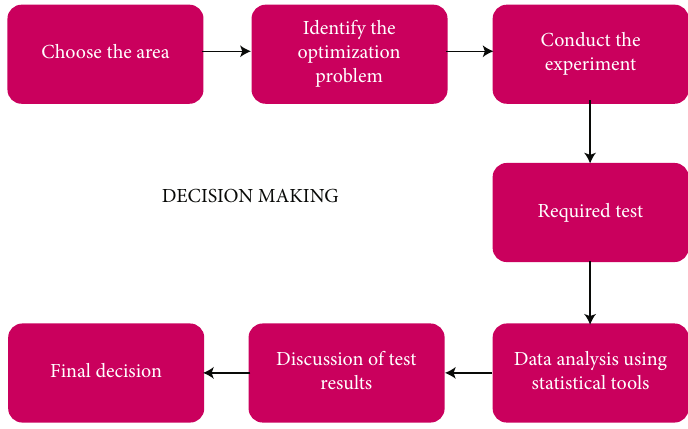
Figure 12: Steps of an experimental optimization tool.